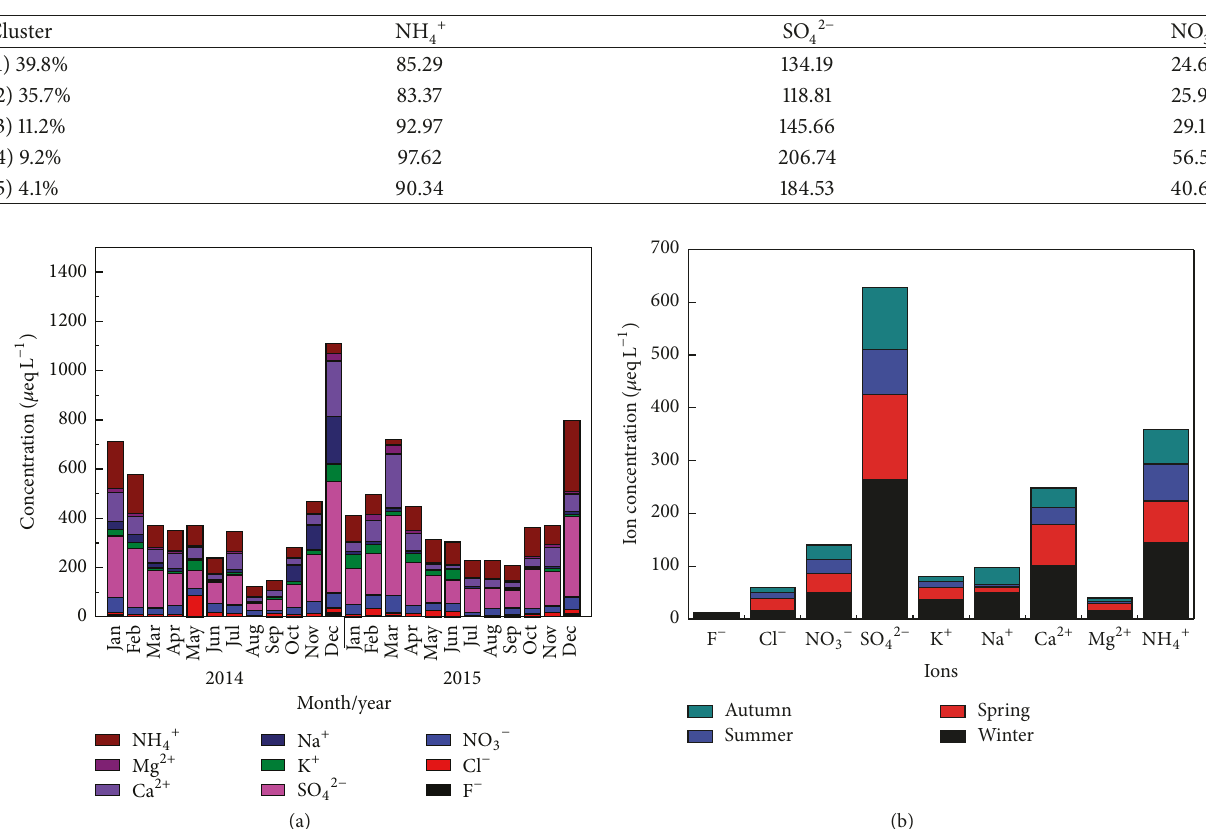
Table 2: VWM concentrations of NH 4+ , SO 42− , and NO 3− in precipitation for the six trajectory clusters during 2014-2015 in Wanzhou (unit: 𝜇 eq L −1 ).